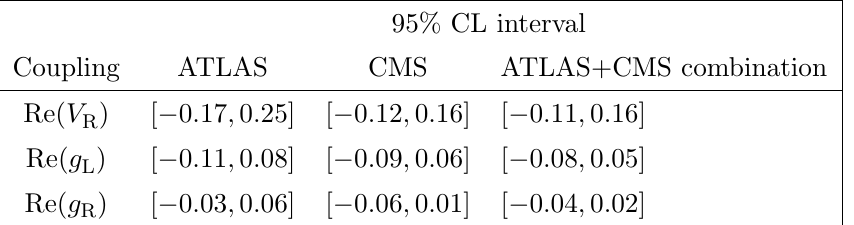
, g , and g at 95% CL. The limit on each R L R